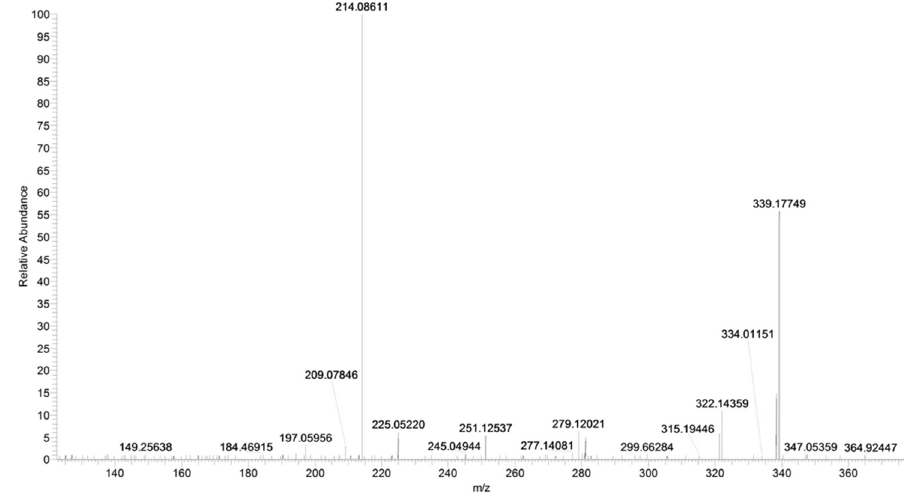
Figure 5. Product ion scan of URB597 compound obtained by QqQ. Exponential scale to base 10. The main fragmentation pathways are driven by α -cleavages to the carbonyl moieties (Table 2, Figure 6).